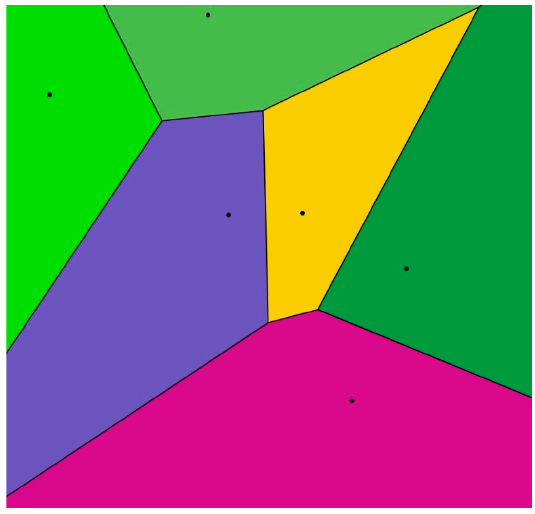
Figure 1. An example of a Voronoi diagram in 2D dimensions.